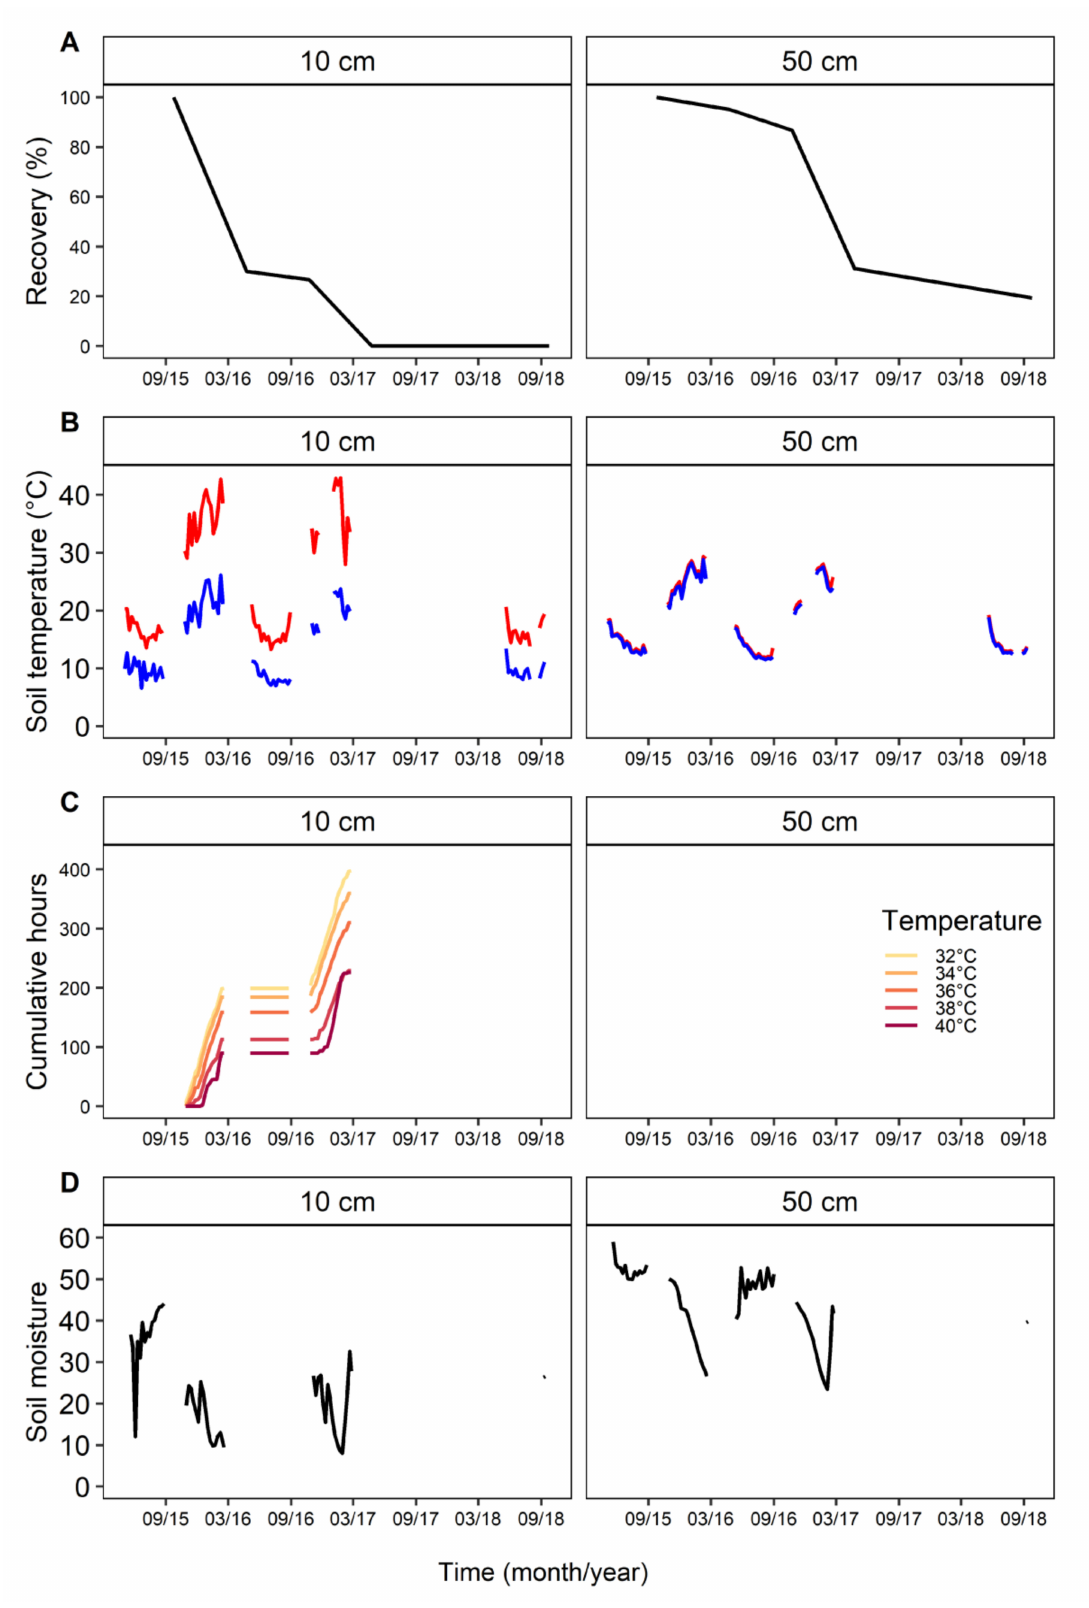
Figure 5. ( A ) Recovery of Phytophthora cinnamomi from Silky Oak stockpile at 10 and 50 cm depth in relation to ( B ) soil temperatures, ( C ) cumulative number of hours of soil temperatures above 32 ◦ C, and ( D ) soil moisture (%). Gaps in temperature and moisture represent missing